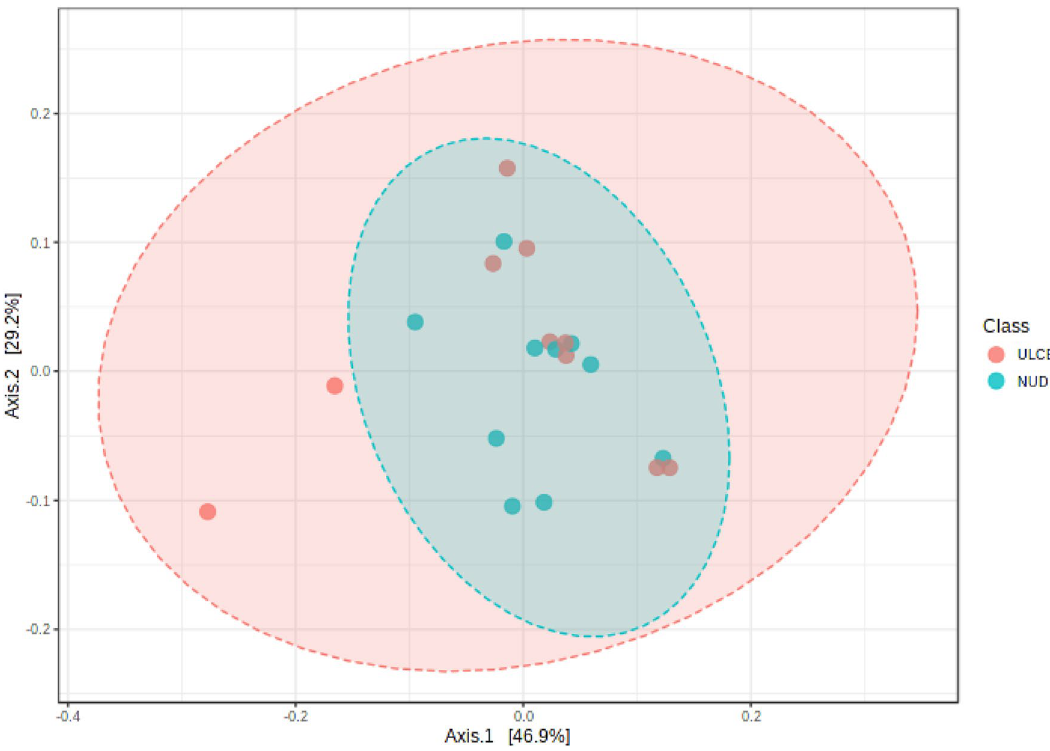
Figure 7. Beta diversity analysis of ulcer and the non-ulcer microbiome plotted in the Principal component analysis (PCoA) in 2D. Bray–Curtis distances were used to explain β-diversity between the two groups. (PERMANOVA) F value = 0.86; R 2 = 0.045; p value < 0.51.